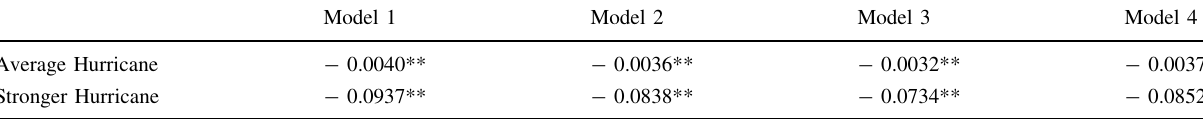
Table 5 Economic impact of hurricanes on production efficiency in the 17 Caribbean countries in the case study